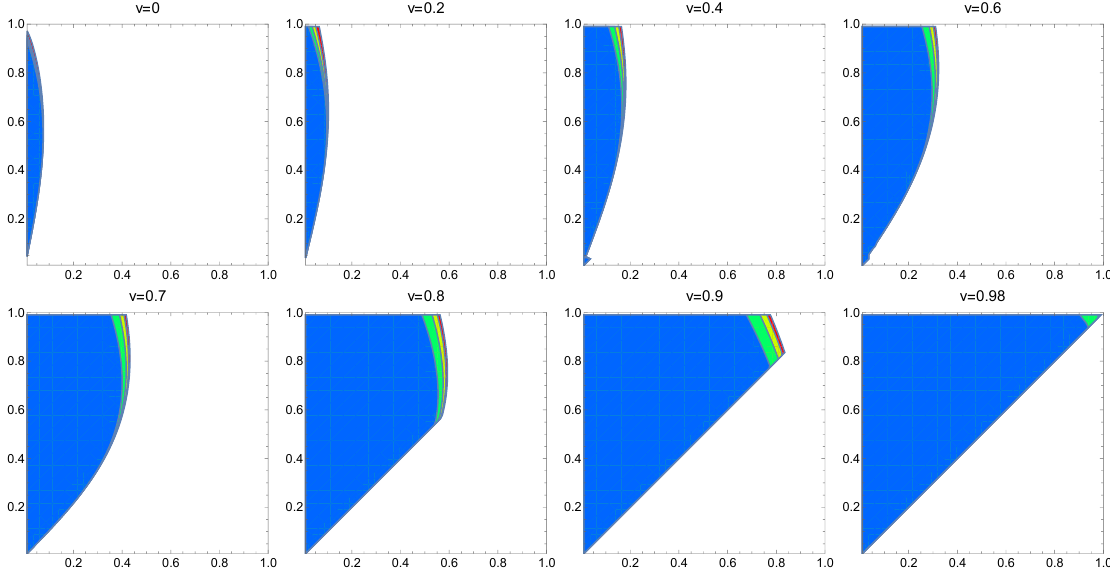
Figure 2. Superposition of stability regions displayed in the ( q 1 , q 2 ) -plane for equilibrium states ( v ∗ , w ∗ ) of system (12) (with parameter values: r = 0.08, d = 0.8), considering several values of the equilibrium membrane potential v ∗ between 0 and 0.98, taking the discretization steps 0.125, 0.25, 0.5 and 1, respectively (the smallest region plotted in blue corresponds to the largest step size h =